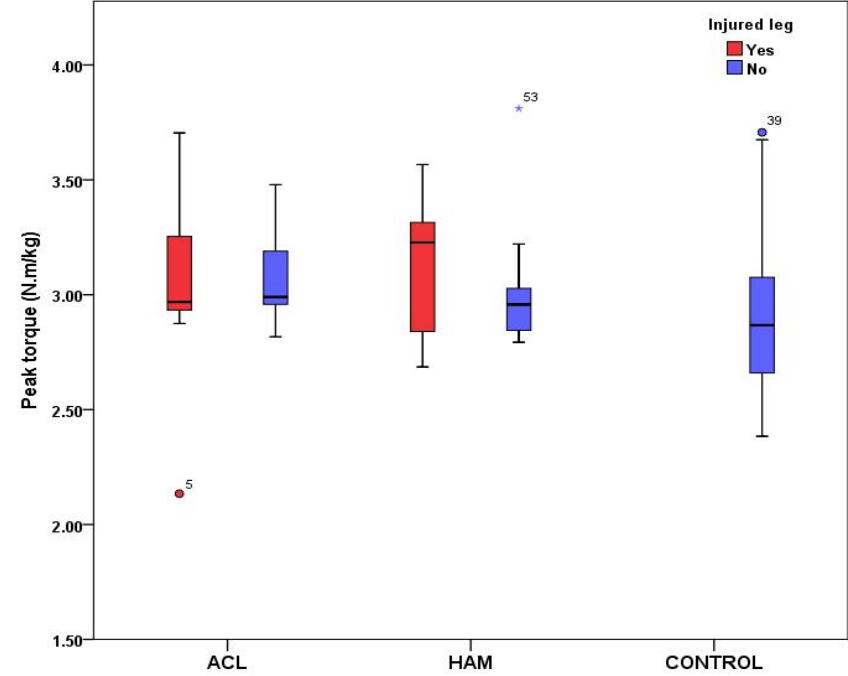
Figure 1. Comparison of knee extensor’s peak torques between observed groups. Note: ACL = anterior cruciate ligament group, HAM = hamstring group, and CONTROL = control group. Table 1. Effect of main factors on the level of knee extensor strength.